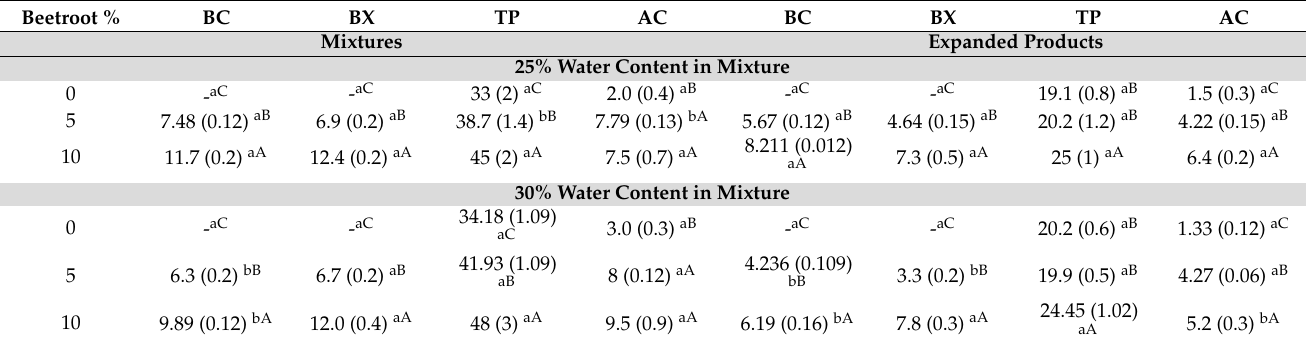
Table 5. Mean value (and standard deviation) of betacyanins (BC, mg BE /100g dry solid ), betaxanthins (BX, mg VE /100g dry solid ) total phenol (TP, mg GAE /100g dry solid ) content, and antioxidant capacity (AC, mg TE /100g dry solid ) of mixtures and